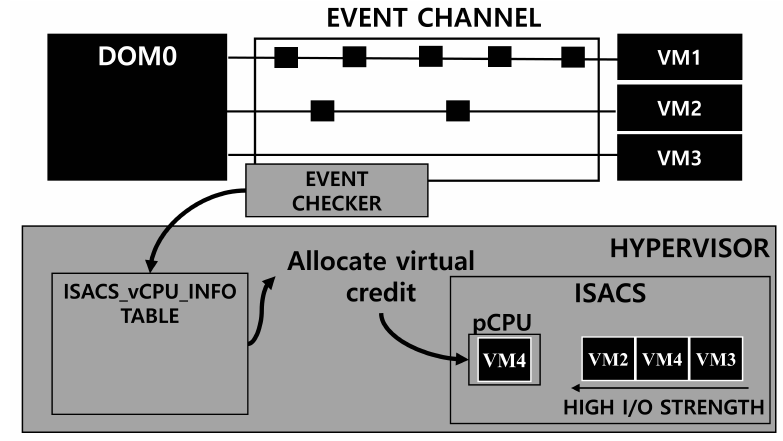
Figure 2. I/O strength-aware credit scheduler (ISACS)